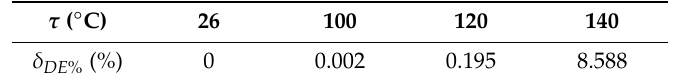
Table 4. Influence of temperature on the degree of demagnetization δ DE% of magnets after start-up process for T L = 19.5 Nm, J i = 0.0082 kgm 2